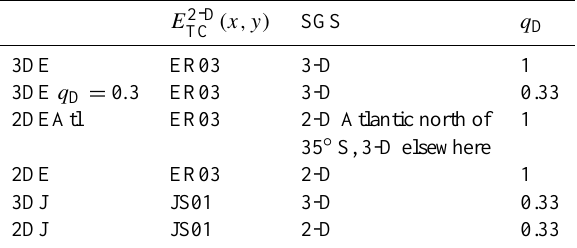
Table 2. Acronyms of climate model experiments performed with different estimates of the barotropic tide energy flux E 2 - D with (3-D) or without (2-D) the subgrid-scale (SGS) bathymetry scheme, and the value for the local dissipation efficiency of the di- urnal tides q D